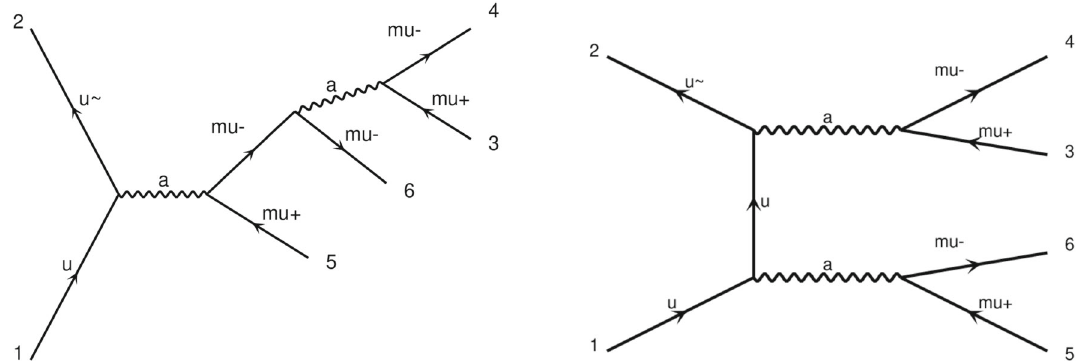
Fig. 1 Typical diagrams contributing to the amplitude of q ¯ q → μ + μ − μ + μ − production. Note that a stands here for either photon or Z